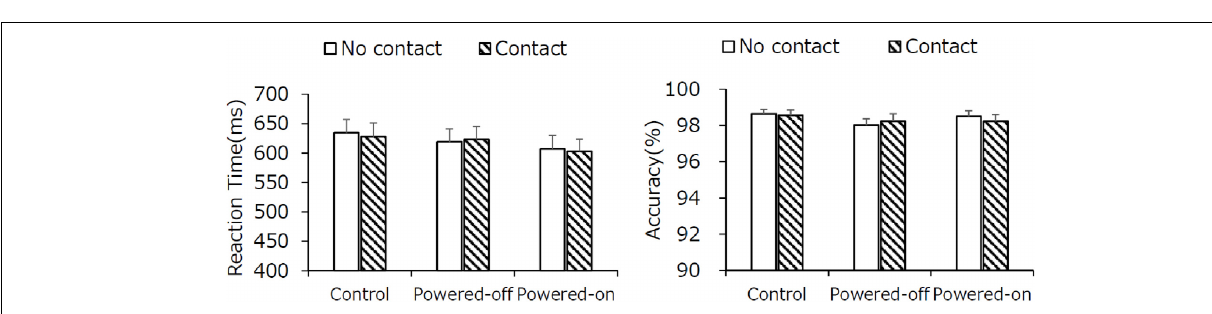
FIGURE 5 | The hit rate of confirmation task per participants in experiment 2.